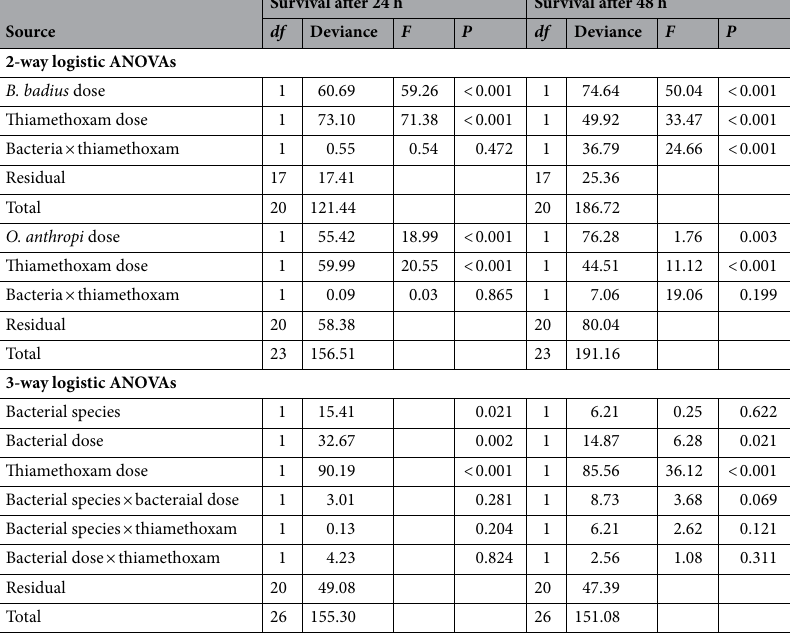
Table 1. Effects of thiamethoxam dose, bacterial dose and species on bee